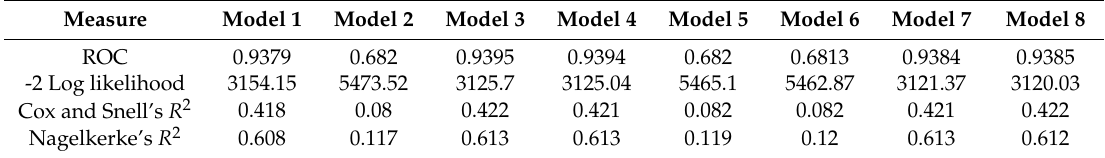
Table 8. Model performance measures for post-GCD